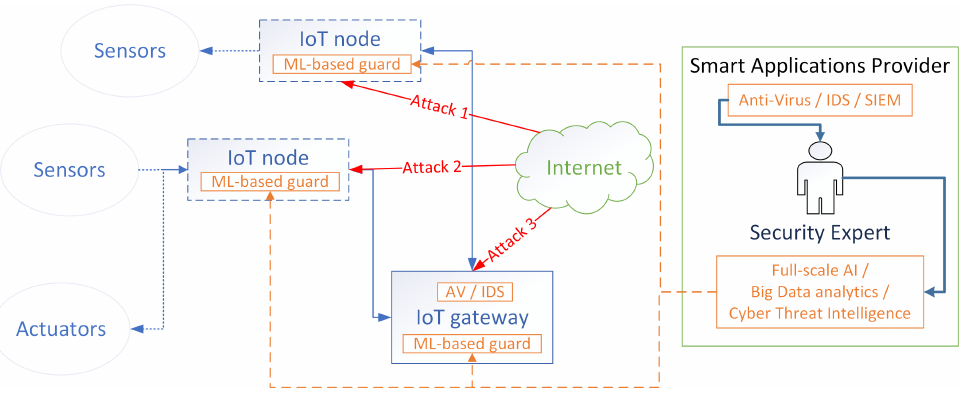
Figure 2. Machine Learning application for cybersecurity hardening in IoT